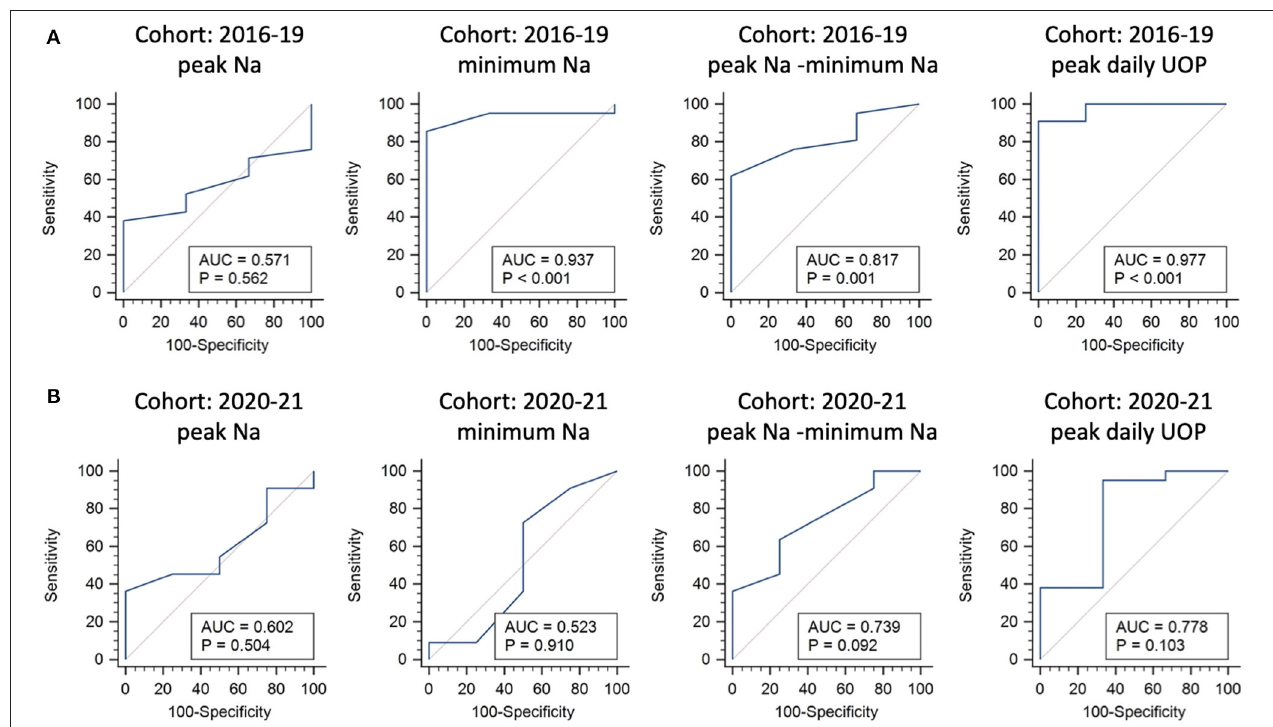
FIGURE 1 | Internal and external validations for predictors of requiring any desmopressin treatment following endonasal endoscopic approach. Receiver operating characteristic curve analysis using the 2016–2019 cohort for internal validation (A) and 2020–2021 cohort for external validation (B)